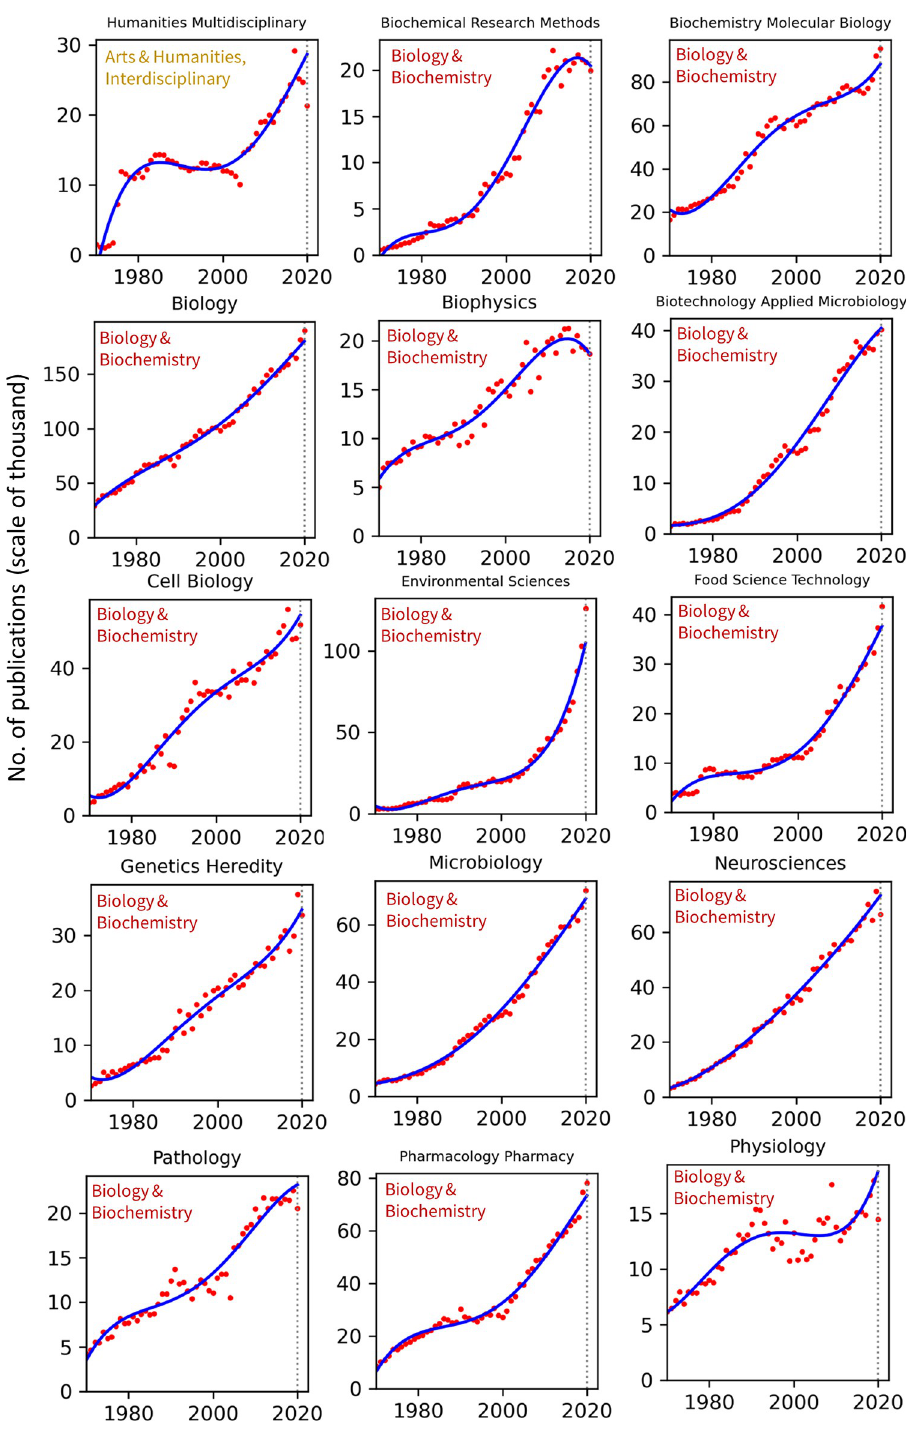
Fig 2. Temporal trends of research productivity in various scientific disciplines (part 1).